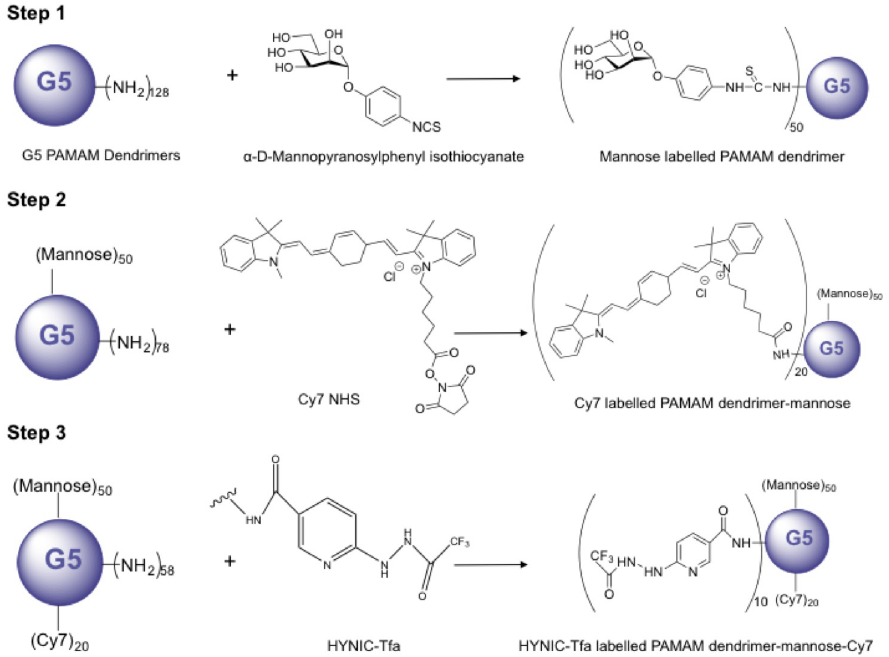
Fig 1. Schematic structure and synthesis method. In step 1, α -D-Mannopyranosylphenyl isothiocyanate was conjugated to -NH 2 group of the dendrimer, using a ratio of 50:1 mannose to dendrimer. In step 2, Cy7 NHS ester was conjugated to -NH 2 group of the dendrimer, using a ratio of 20:1 Cy7 to dendrimer. In step 3, Suc-HYNIC-Tfa was conjugated to -NH 2 group of the dendrimer, using a ratio of 10:1 Suc-HYNIC-Tfa to dendrimer.